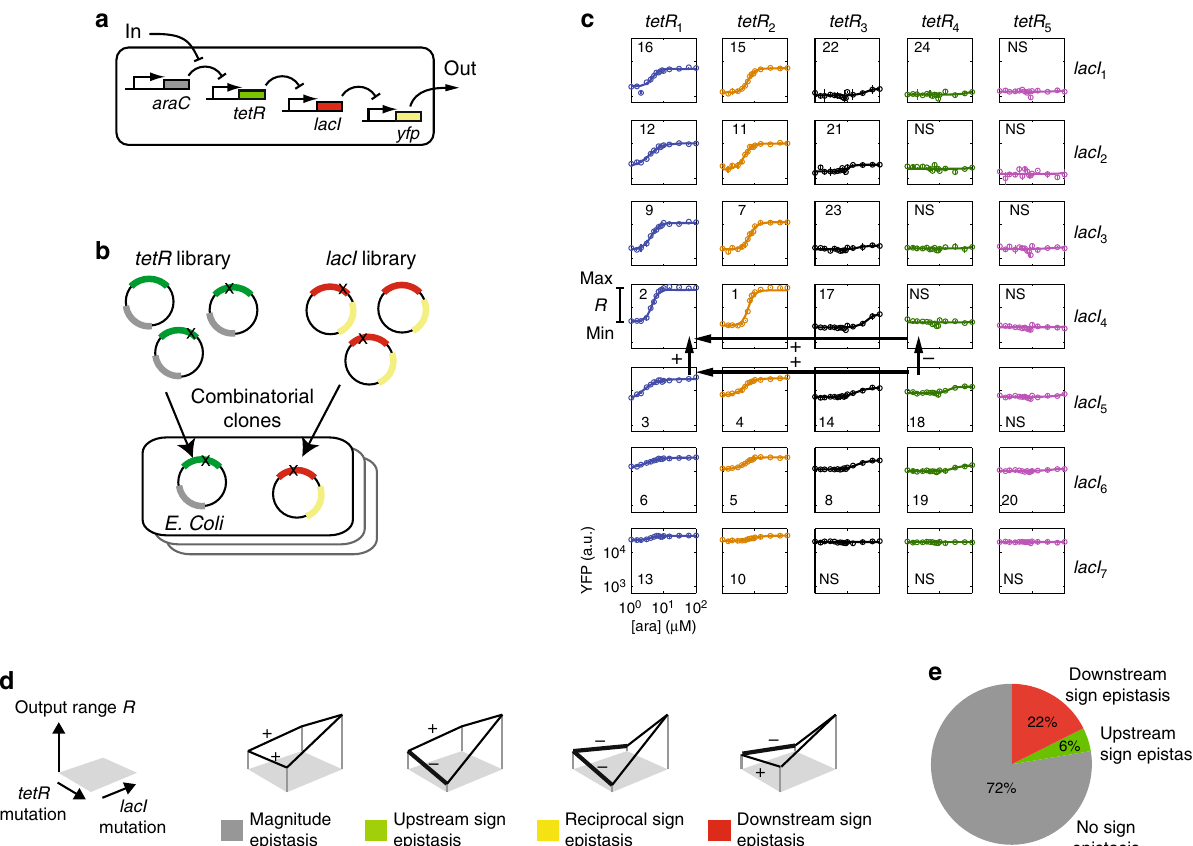
Fig. 1 Sign epistasis in combinatorial regulatory cascades. a Experimental system: tetR and lacI genes transduce the arabinose input (in) into a YFP expression output (out). b Mutation strategy: randomly mutated tetR and lacI variants encoded on two separate vector plasmids were transformed in combinatorial fashion into E . coli cells. c YFP versus arabinose responses for all combinations of the fi ve tetR and seven lacI variants, including the wild-type. Signal transduction ability for each variant is quanti fi ed by R = out max – out min (see tetR 1 – lacI 4 variant). Numbers indicate ranking of R values for each mutant, with 1 corresponding to the highest R , and NS indicates non-signi fi cantly increasing responses, compared to measurement noise ( p < 10 − 3 , two- sided Welch t -test, Methods section). The four black arrows indicate an example of sign epistasis: R decreases when fi rst mutating lacI , but increases for all other mutations. Error bars are s.d. over the mean for n = 3 biological replicates. tetR and lacI mutants are ordered by their operator dissociation constant, with the top-left showing the most tightly binding variants. d Classes of sign epistasis between tetR and lacI mutations and associated colour code. Thick lines have a minus sign and indicate decreases in R . e Fractions of empirically observed epistasis classes for all possible double mutants (pairwise interactions), when R is determined over the full arabinose input range. Downstream sign epistasis is